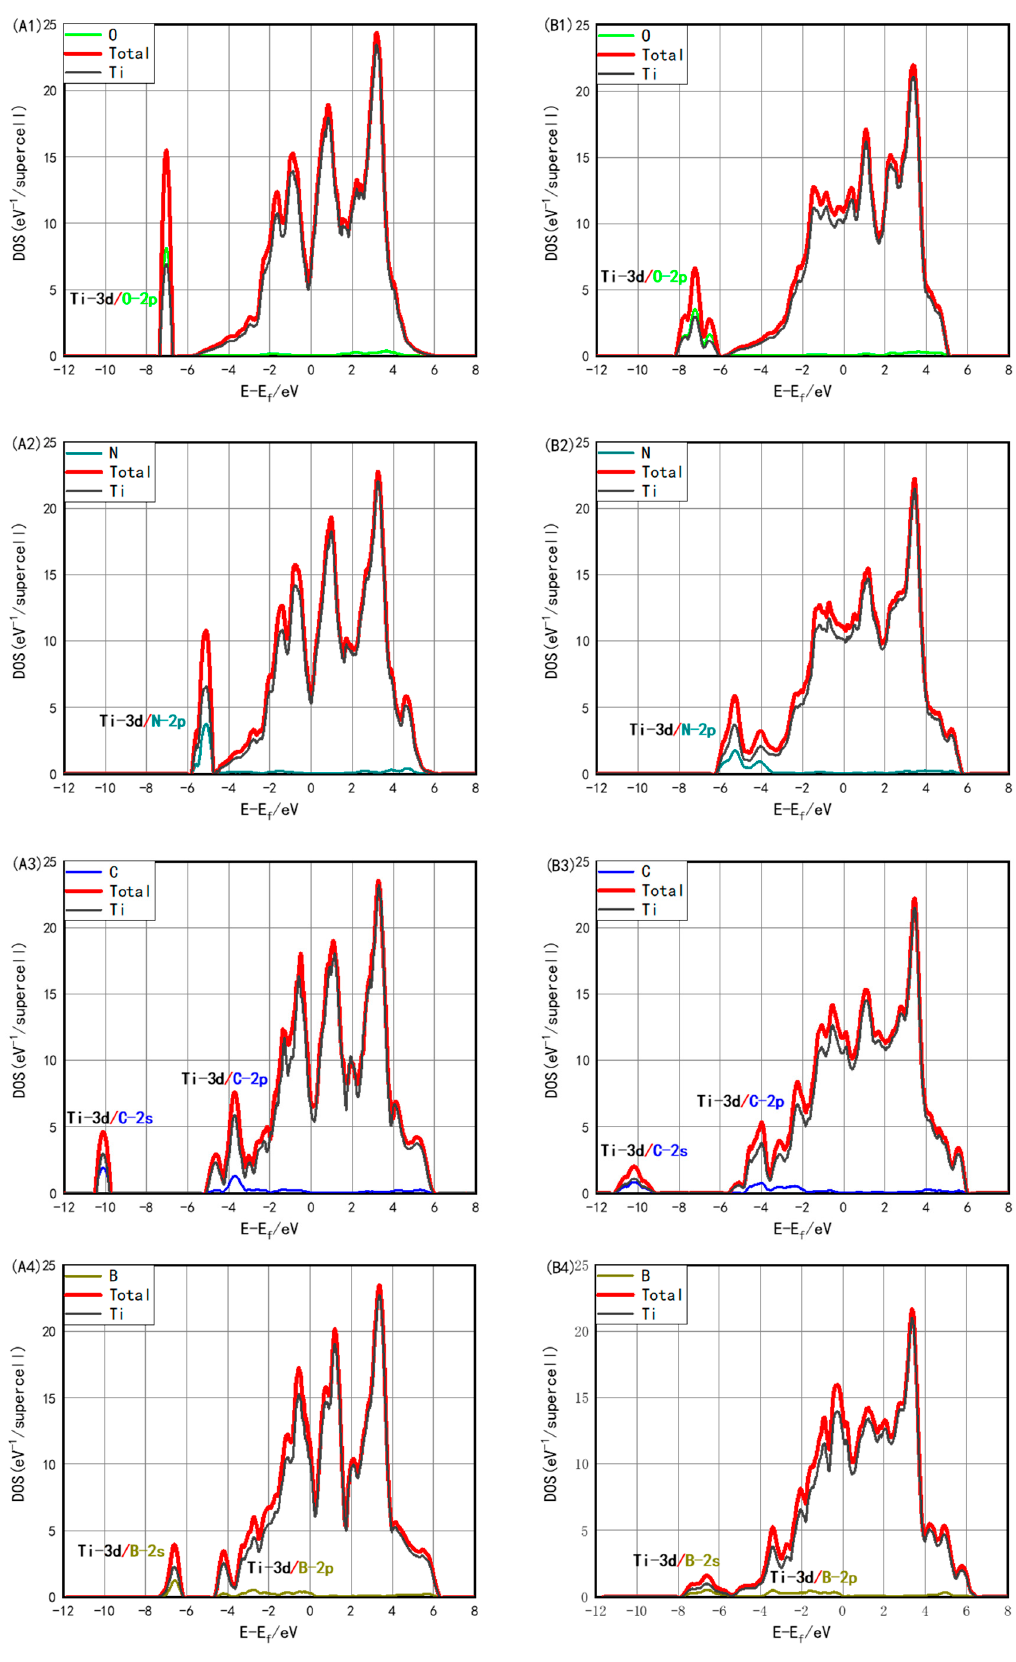
Figure 4. Total and projected density of states (PDOS) in HCP-Ti ( A1 – A4 ) and FCC-Ti ( B1 – B4 ) with interstitial B, C, N and O.